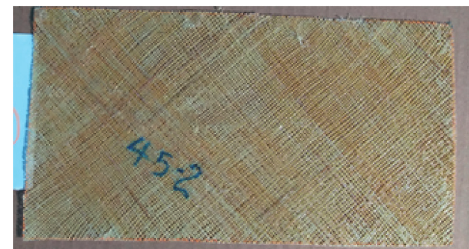
Figure 4: Prepared prepregs (dimension: 280mm × 150 mm).